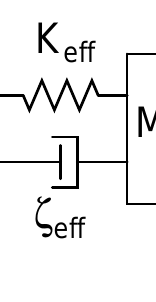
Figure 1. A mass-spring-damper system.